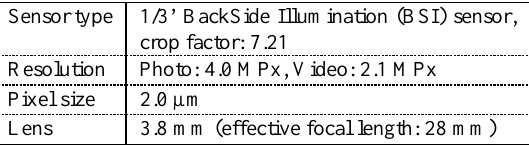
Table 1: HTC One M7, Camera specifications